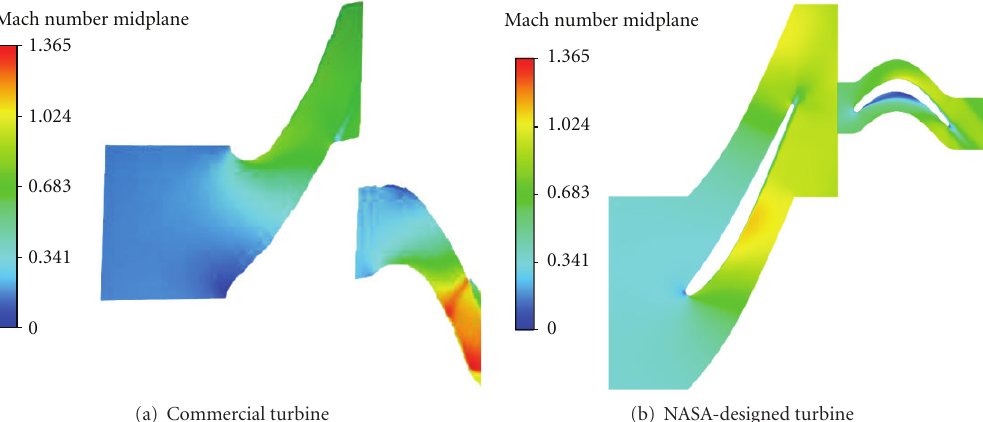
Figure 11: Mach number contours at the 50% blade span.